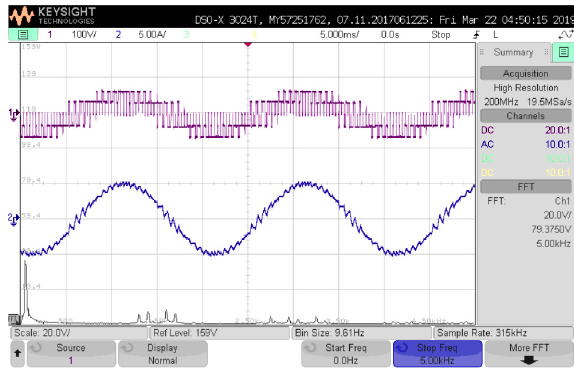
Figure 4. Voltage (top) and current (middle) waveforms of the phase a along with the V a spectrum (bottom) for the reference voltage m 1 = 1.15 and m 2 =